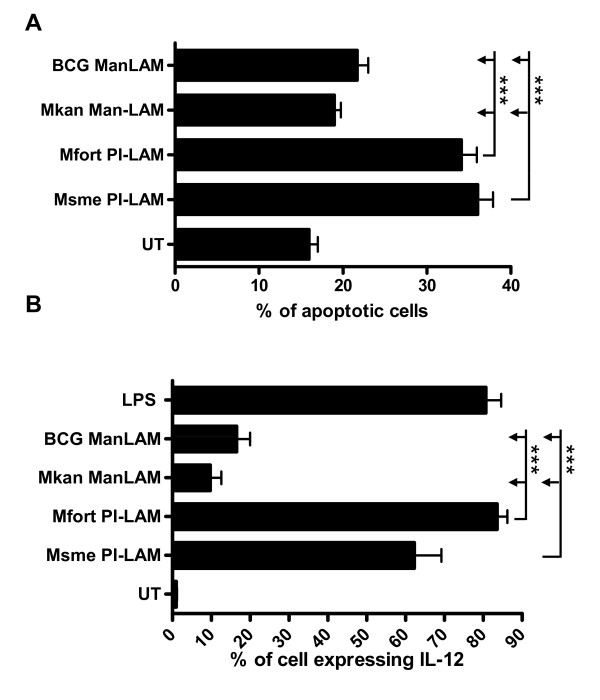
PI-LAM of fast-growing mycobacteria induces apoptosis and IL-12 gene expression in macrophages. A. Differentiated human THP-1 cells were not treated (UT) or incubated with the indicated lipoglycans at 20 μg/ml for 24 h. The percentage of apoptotic cells was determined as Annexin-V-Alexa488-positive and propidium iodide-negative cells out of 10,000 analyzed cells by flow cytometry. B. The induction of Il-12 gene expression was analyzed by incubating a murine macrophage (RAW/pIL-12-GFP) reporter cell line which has the IL-12p40 promoter in front of the GFP gene, with the indicated lipoglycans for 16 h. GFP-expression was analyzed on 5,000 cells and the mean and standard deviation of three independent experiments is shown.